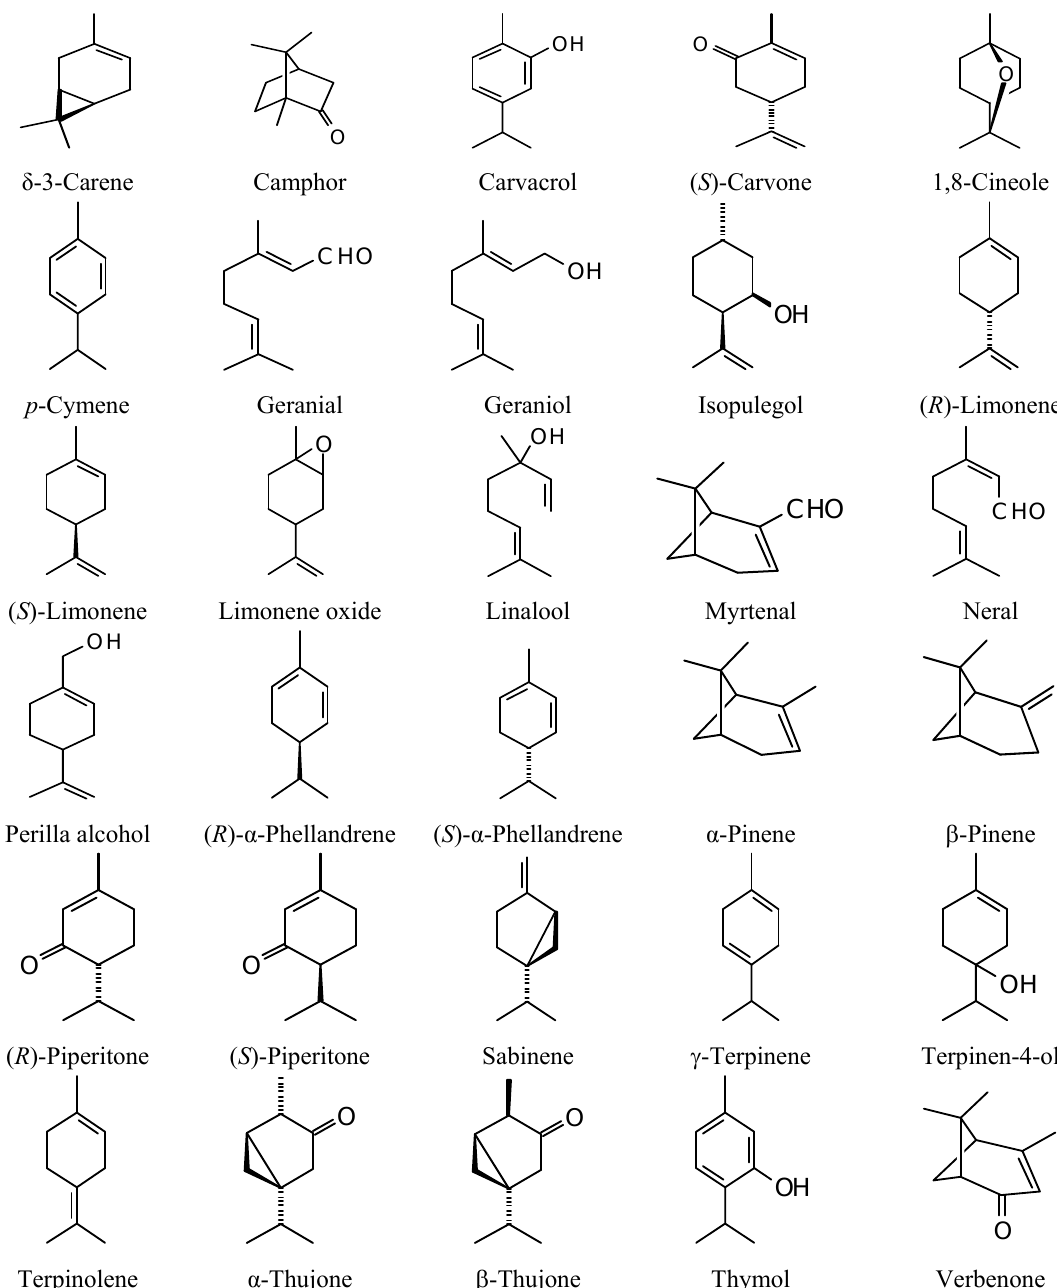
Figure 1. Monoterpenoids examined in this